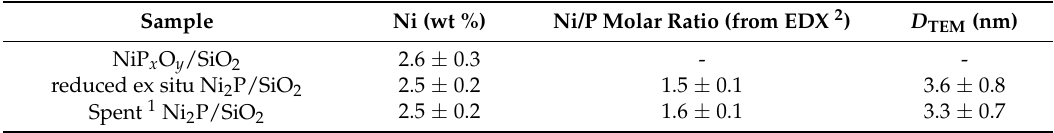
Table 1. Physicochemical properties of the calcined NiP x O y /SiO 2 precursor and Ni 2 P/SiO 2 catalysts.